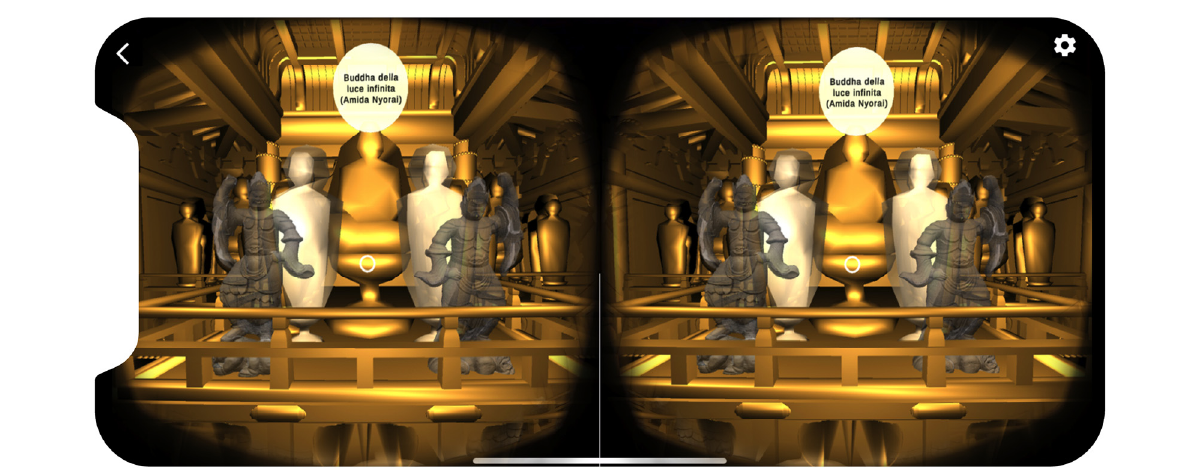
Figure 8 . Screenshots of the VR experience for cardboard. Editing S.